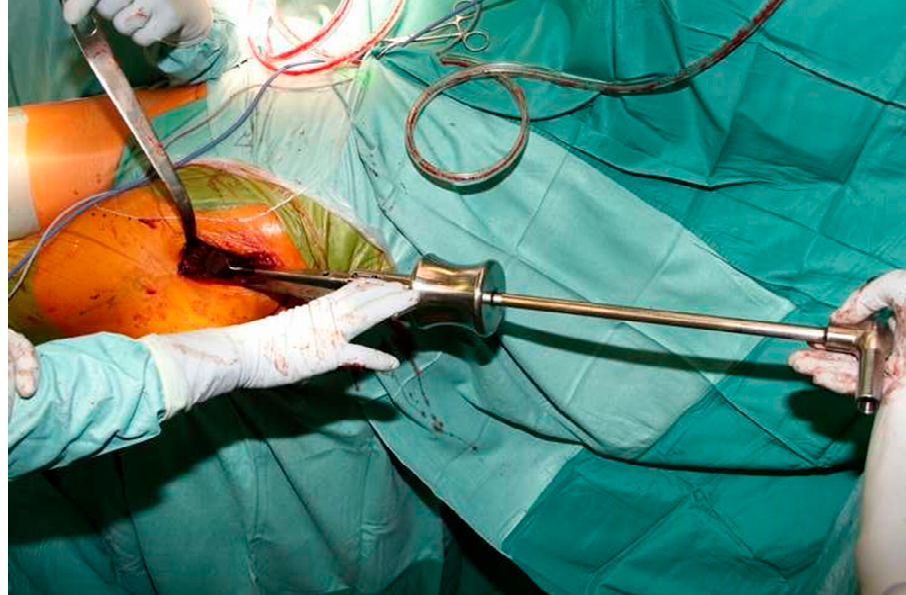
Figure 1. Intraoperative photograph showing straight access to the femur after tensor fascia latae (TFL) release using the Direct Anterior Approach (DAA) interval .